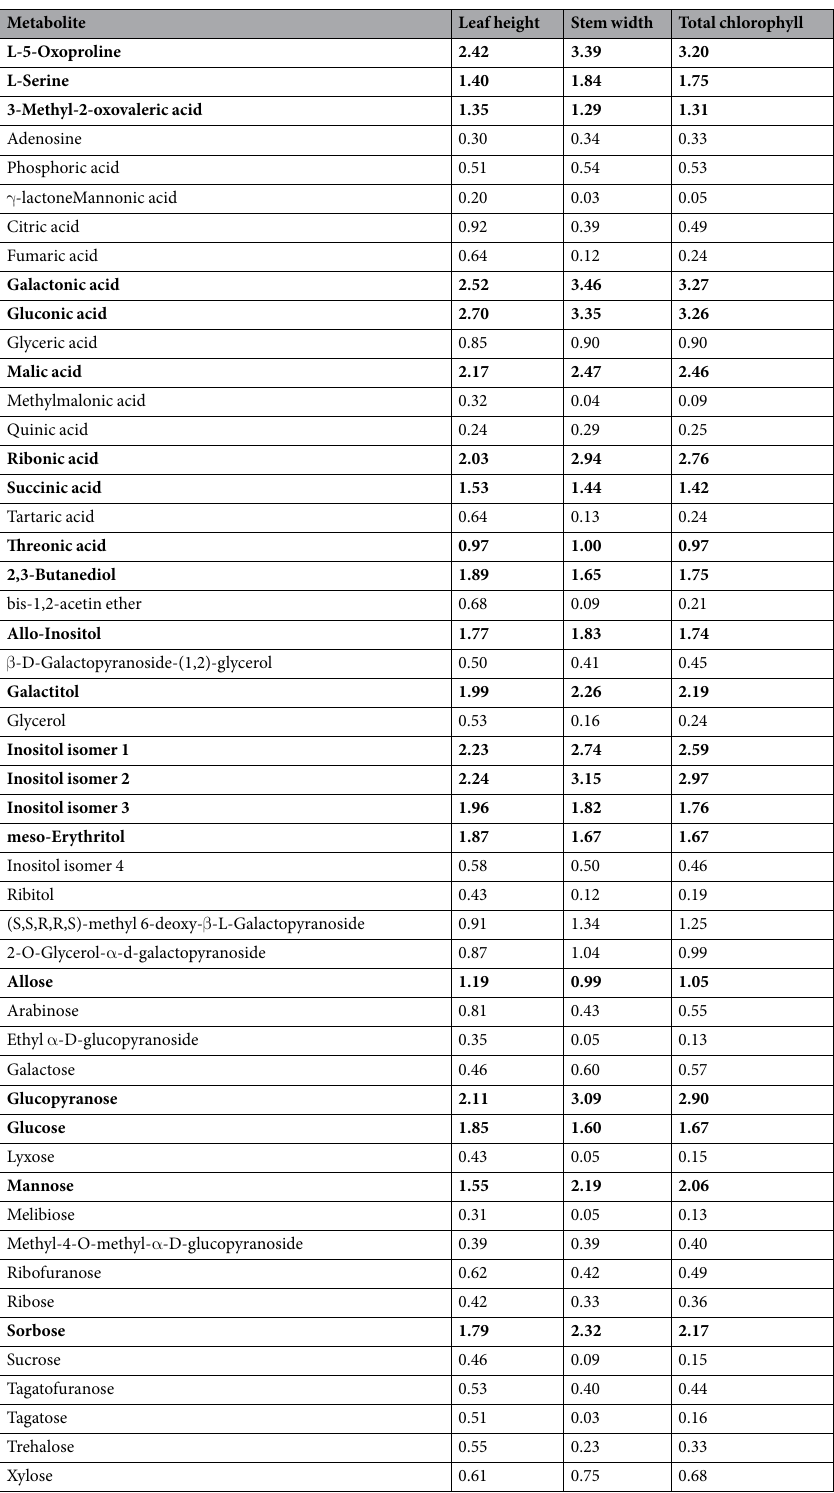
Table 1. VIP scores for the concentration of metabolites in lettuce crops in response to CEC stress exposure for the three morphological-physiological parameters measured: leaf height, stem width and total chlorophyll content. Metabolites in bold indicate that VIP scores >